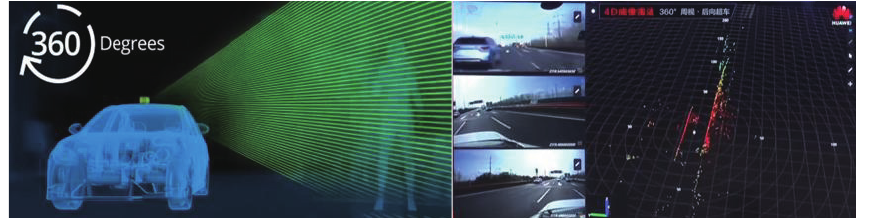
Figure 5. Demonstration diagram of the unmanned driving process with mechanical LIDAR and pure solid-state LIDAR. The webpage referenced in this figure is